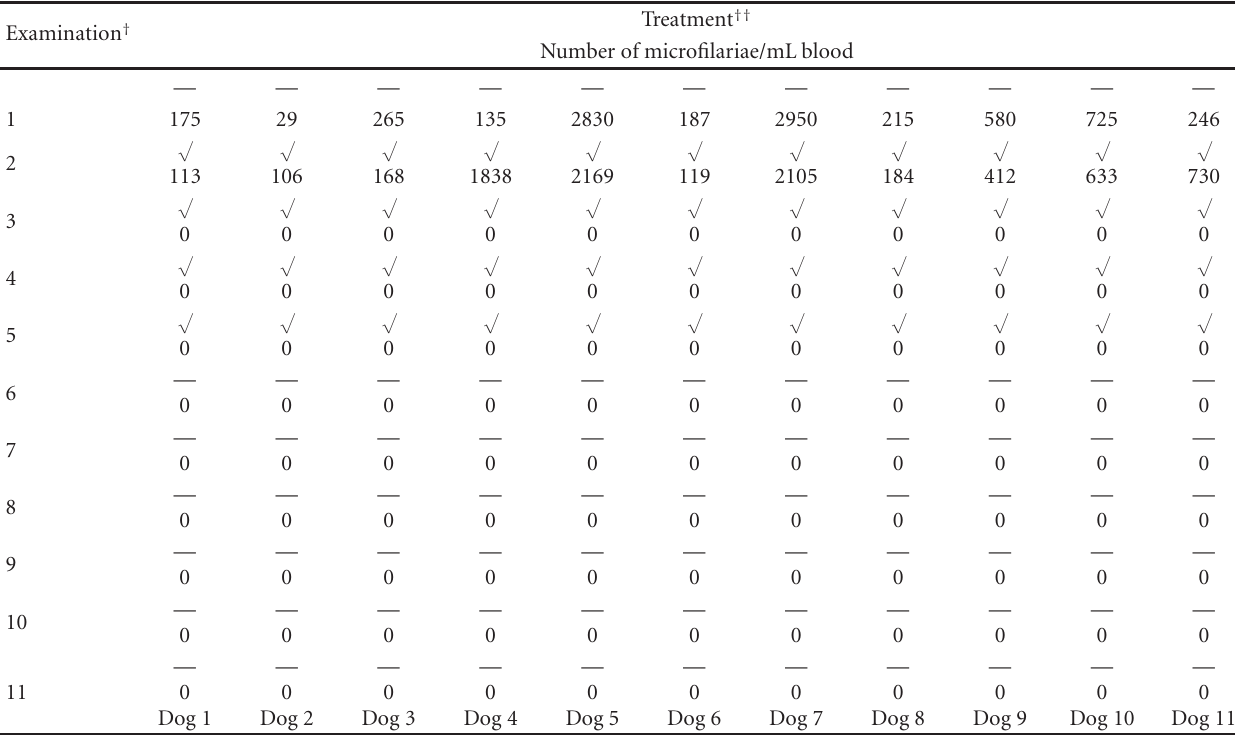
Table 1: The influence of Advocate on the presence of Dirofilaria repens microfilariae in the blood of tested